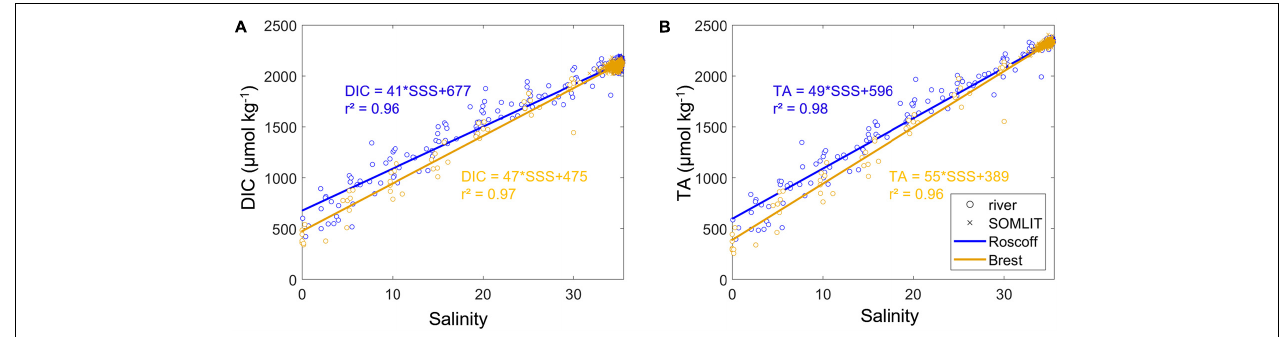
FIGURE 2 | Linear regressions between (A) dissolved inorganic carbon concentration (DIC, µ mol kg - 1 ) and sea surface salinity (SSS), and (B) total alkalinity (TA, µ mol kg - 1 ) vs. SSS based on the data collected at Penze/Morlaix rivers (blue circles) in 2010–2011 and 2019–2020 and Roscoff stations (SOMLIT-pier and SOMLIT-offshore, blue asterisks) from 2008 to 2019 and Elorn and Aulne rivers (orange circles) in 2009–2010 and SOMLIT-Brest (orange asterisks) from 2008 to 2019.